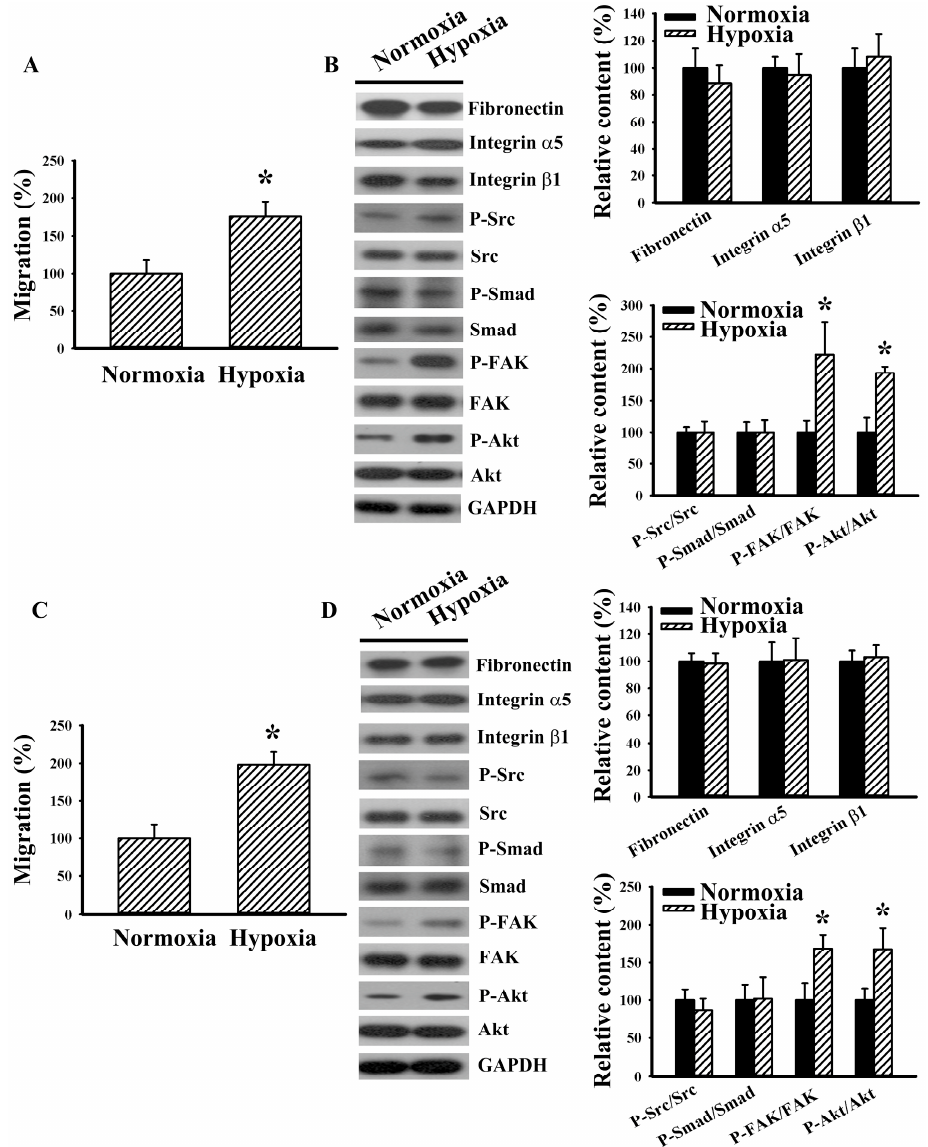
Figure 8. Hypoxia increased RCC cell migration. ( A ) 786-O cells were seeded onto Transwell inserts and subjected to Transwell migration assay in a normoxia or hypoxia incubator (1% O 2 , 5% CO 2 , and 94% N 2 ) for 8 h. The lower chambers were filled with DMEM containing 10% FBS. ( B ) 786-O cells were placed in a normoxia or hypoxia incubator (1% O 2 , 5% CO 2 , and 94% N 2 ) for 8 h. Proteins were extracted and subjected to Western blot analysis with indicated antibodies. Representative blots are shown. ( C ) Caki-1 cells were seeded onto Transwell inserts and subjected to Transwell migration assay in a normoxia or hypoxia incubator (1% O 2 , 5% CO 2 , and 94% N 2 ) for 8 h. The lower chambers were filled with DMEM containing 10% FBS. ( D ) Caki-1 cells were placed in a normoxia or hypoxia incubator (1% O 2 , 5% CO 2 , and 94% N 2 ) for 8 h. Proteins were extracted and subjected to Western blot analysis with indicated antibodies. Representative blots are shown. Bar graphs show quantitative results among groups and the value in normoxia group was defined as 100% ( A – D ). * p < 0.05 vs. normoxia control, n = 3.